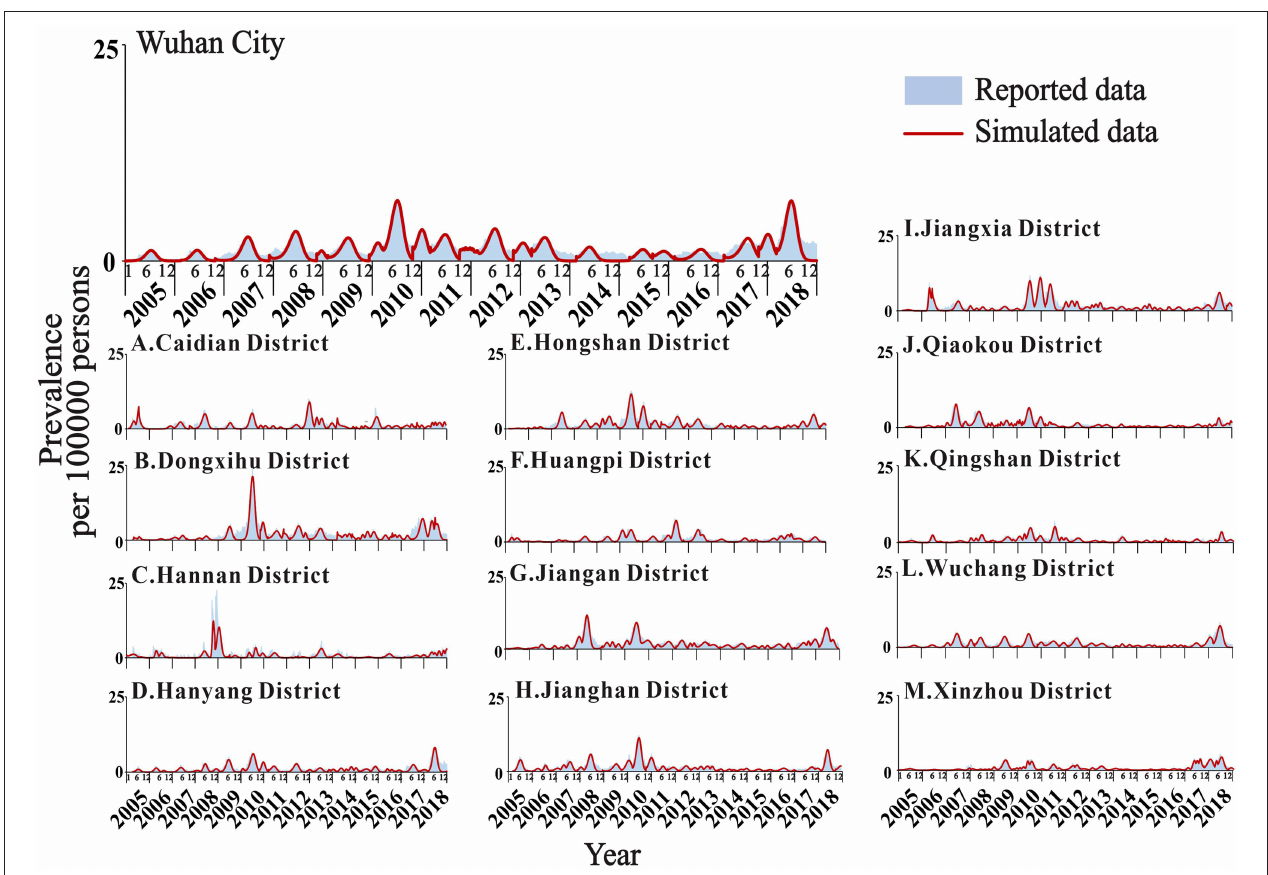
FIGURE 6 | Fitting results of mumps cases in Wuhan City and the 13 districts.